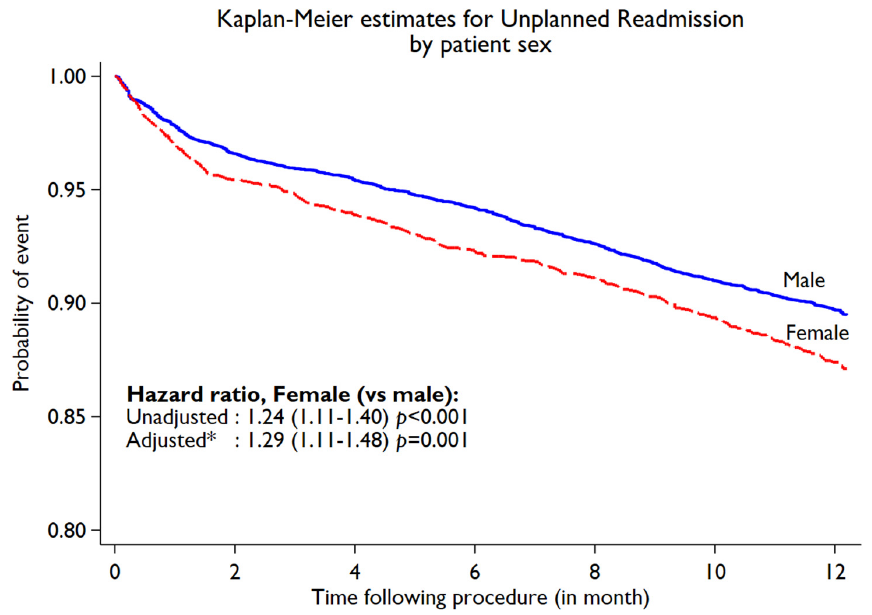
Figure 2. Kaplan–Meier curve for unplanned cardiac readmissions within first year following PCI by sex. * Adjusted for age, diabetes, BMI, hypertension, hypercholesterolemia, previous history of MI, PVD, or CABG, smoking, renal dysfunction, pci presentation, and multivessel disease.